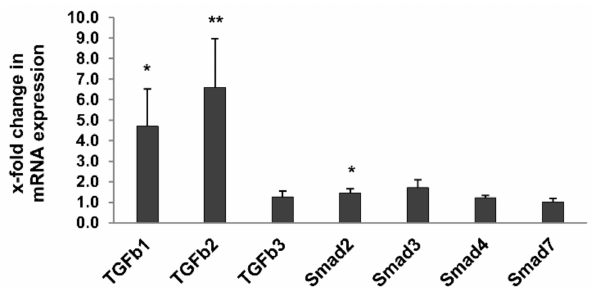
Figure 5. Expression of TGF- β pathway-specific genes in kidneys of 3- and 24-month-old rats by RT-qPCR. Expression of TGF- β 1, TGF- β 2 and Smad2 was significantly higher in 24-month-old rats compared to 3-month-old rats, while expression of TGF- β 3, Smad3, Smad4 and Smad7 was not significantly affected. Data was normalized with respect to the corresponding values determined in 3-month-old rats. For all figures p -values ≤ 0.05, and ≤ 0.01 are indicated by one or two, respectively.